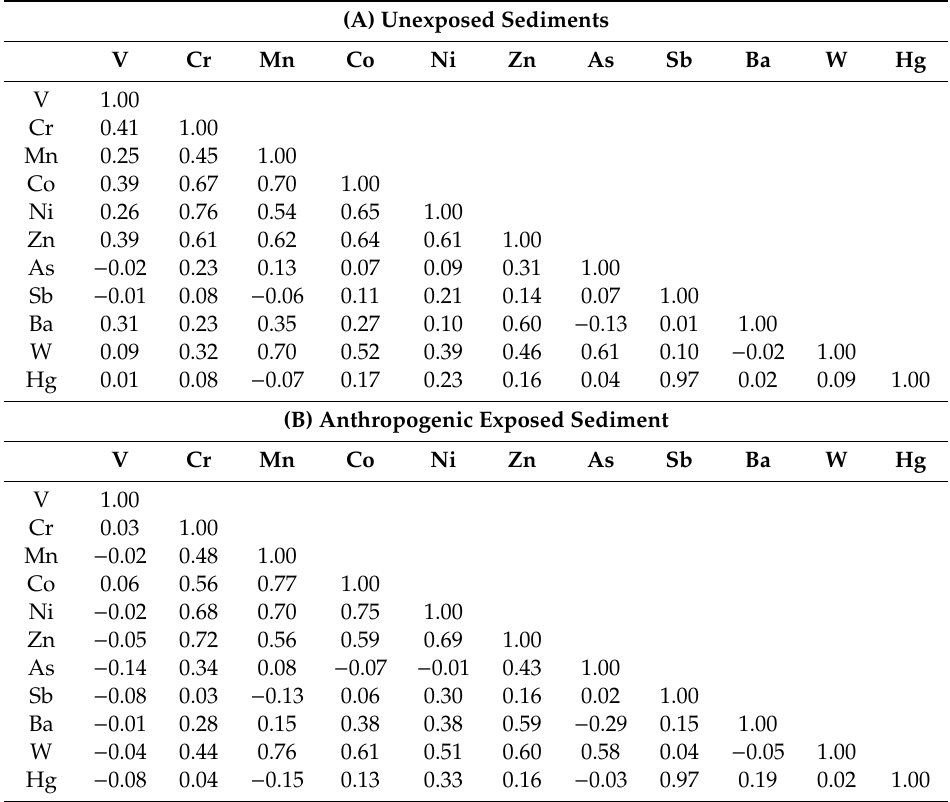
Table 4. Matrix of the Spearman’s correlation coe ffi cient of presumed contaminant elements in sediment samples (in bold correlation coe ffi cients at p <